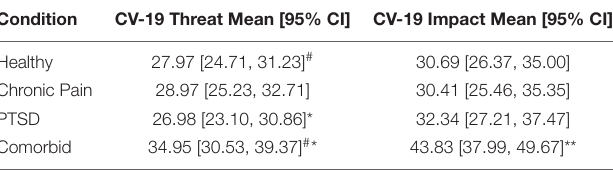
TABLE 2 | Estimated marginal means and Tukey’s HSD comparisons.